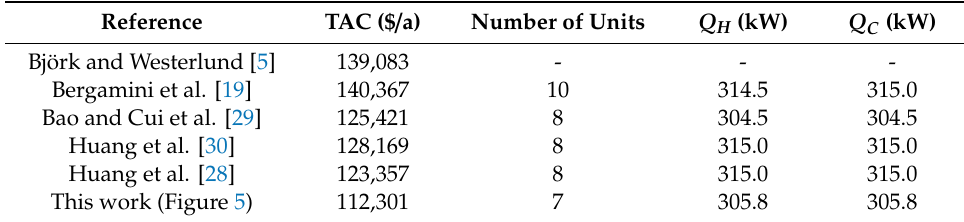
Table 5. Stream, cost, and parameters of case 3.